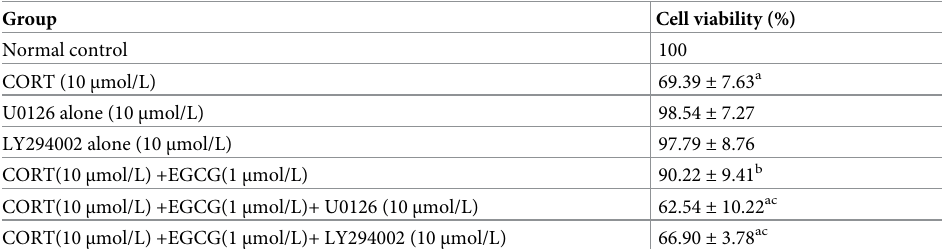
Table 1. The effects of U0126 and LY294002 on EGCG-mediated neuroprotection against corticosterone-induced cell death (mean ± standard